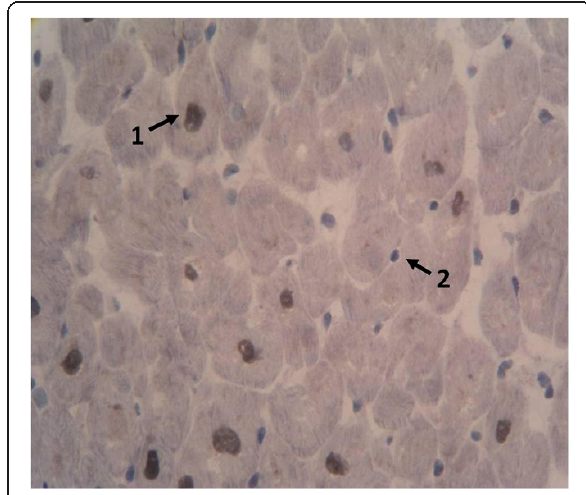
Figure 2 Insulin-like growth factor 1 (IGF-1) immunohistochemical expression in myocardium at 10 μ m (magnification ×400). (1) IGF-1 positive nuclear expression. (2) Negative nucleus without IGF-1